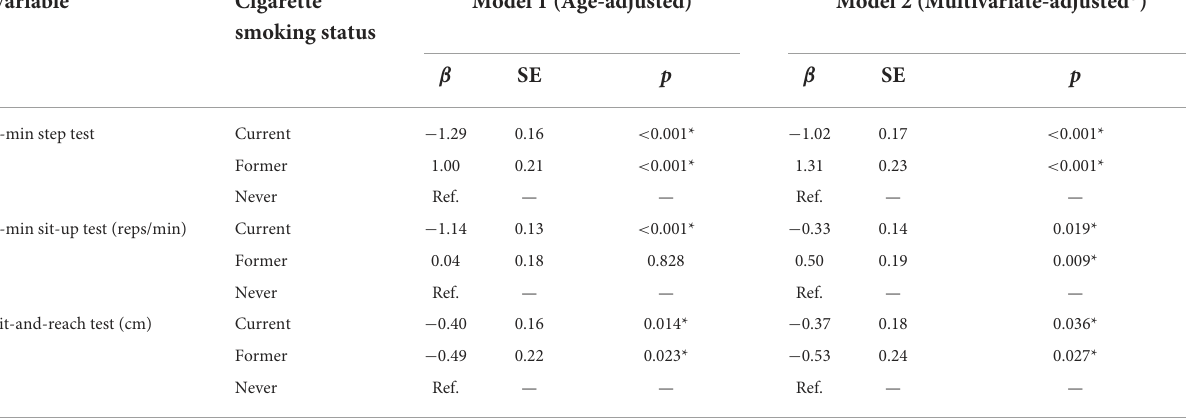
TABLE 3 Multiple regressions for the association between cigarette smoking status and health-related physical fitness after adjusting for potential confounders.